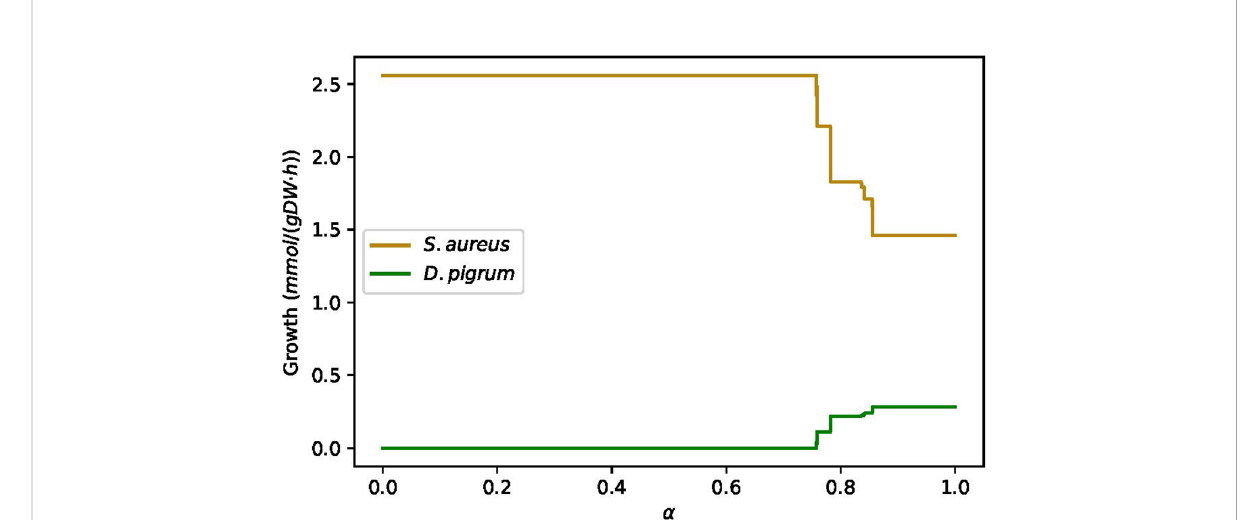
FIGURE 10 The D. pigrum is used in the absence of amino acids L-isoleucine and L-methionine, as well as metabolite 2,6-diaminoheptanedioate while S. aureus grows on SNM3. The fi gure represents by which factor of a S. aureus provides the necessary metabolites for D. pigrum to allow it to grow. The community objective function is de fi ned as a % MBR DP + (1 − a )% MBR SA and the medium is assumed to be